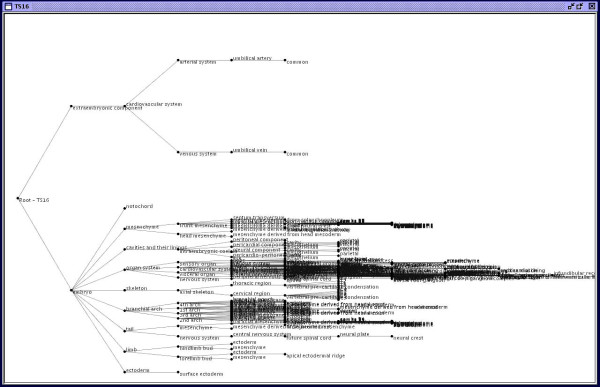
Unweighted distribution of nodes in L-R layout for TS16. The bottom half of the graph has a very high level of occlusion; TS16 contains 572 nodes. Without weighting the top half of the graph lies mostly empty, containing only 8 nodes.